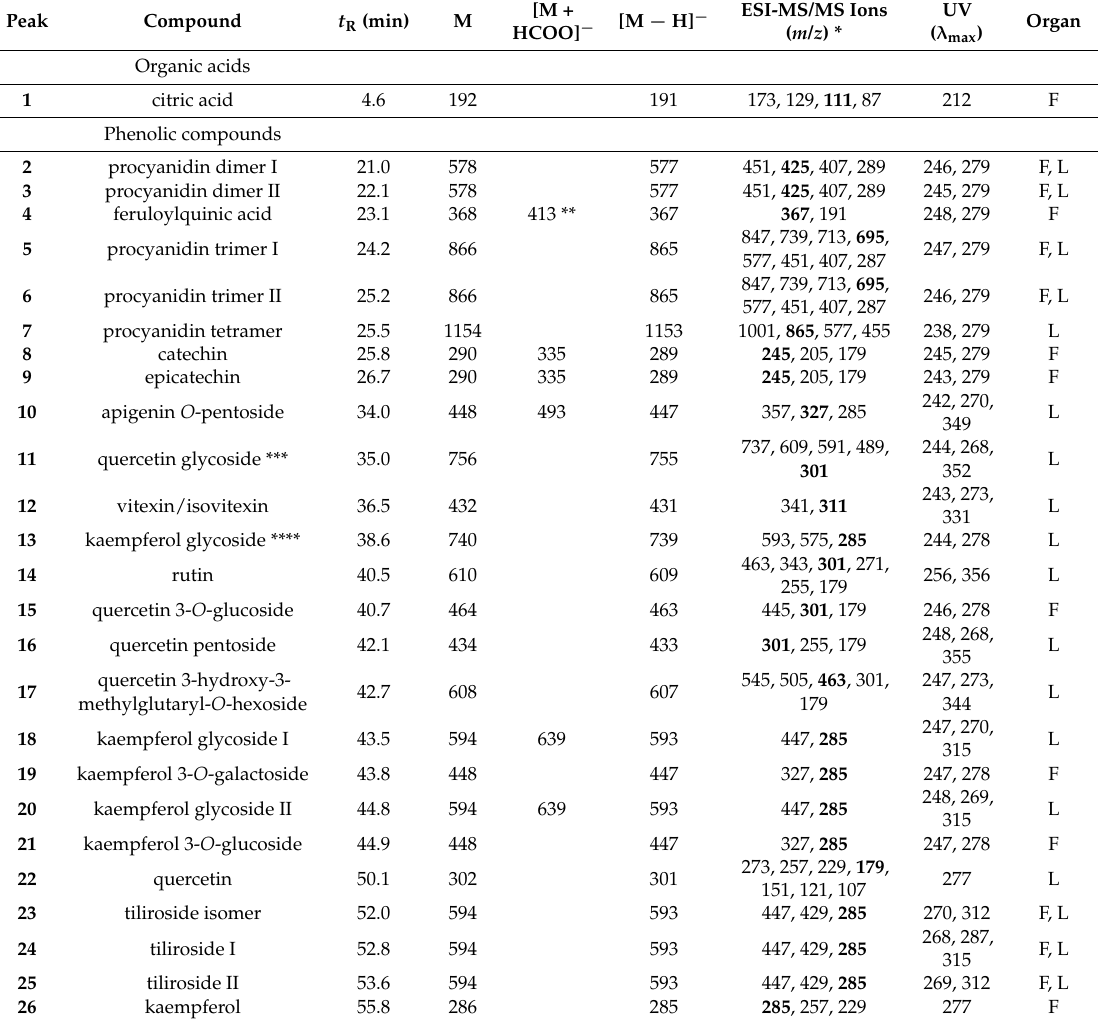
Table 2. Mass/UV spectral data and retention time ( t R ) of compounds 1 – 26 detected in the baobab fruit pulp (F) and leaves (L). Compound numbers correspond with peak numbers in Figure 4. Compounds are listed in order of increasing t R